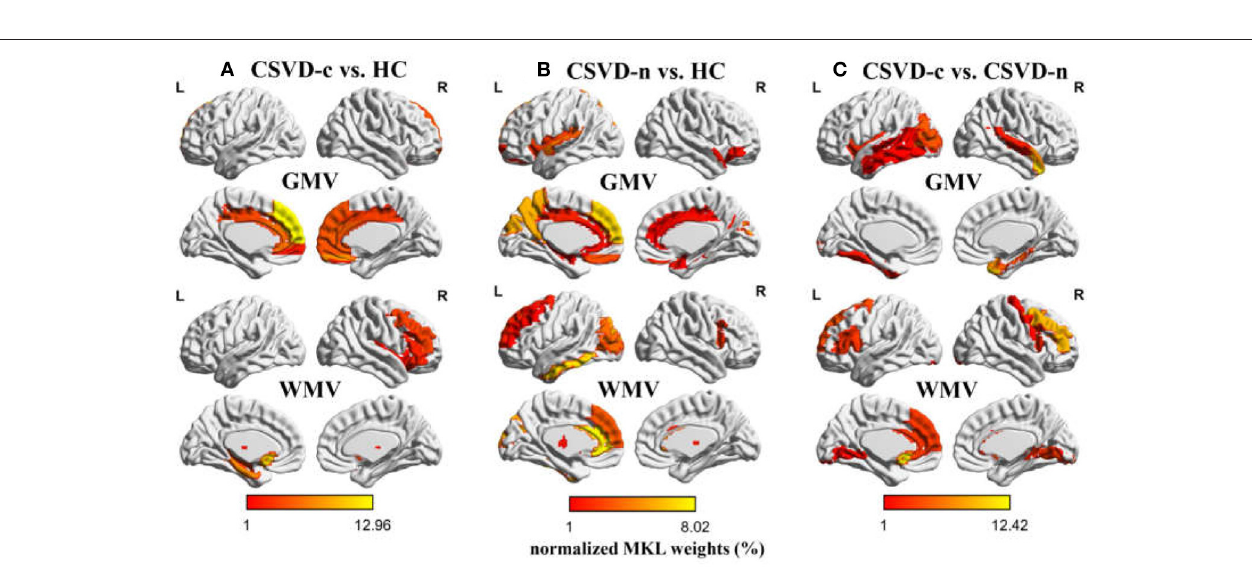
FIGURE 4 | Receiver operating characteristic (ROC) curve for (A) CSVD-c vs. HC, (B) CSVD-n vs. HC, and (C) CSVD-c vs. CSVD-n classification problems. HC, healthy controls.